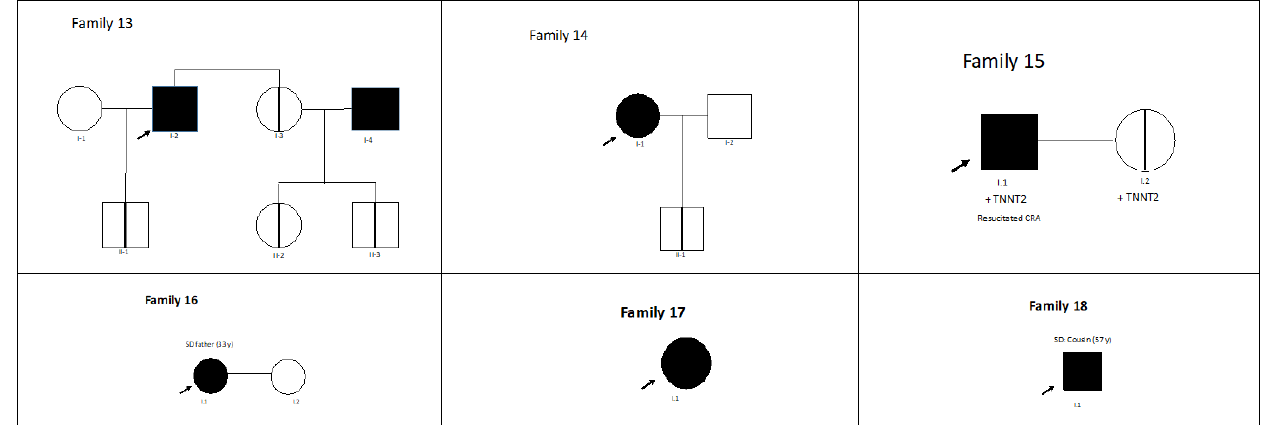
Figure 2. Pedigree of families with hypertrophic cardiomyopathy, carrying MYBPC3 p.Val931Glyfs*120. SD, sudden death; SCA, sudden cardiac arrest. Symbols denote sex and disease status: box, male; circle, female; darkened, phenotype of hypertrophic cardiomyopathy; slashed, deceased; clear symbol, unaffected; without sign, not studied; N, noncarriers; vertical line, carrier without phenotype of hypertrophic cardiomyopathy; ?, unknown phenotype. Index cases signaled by black arrows.